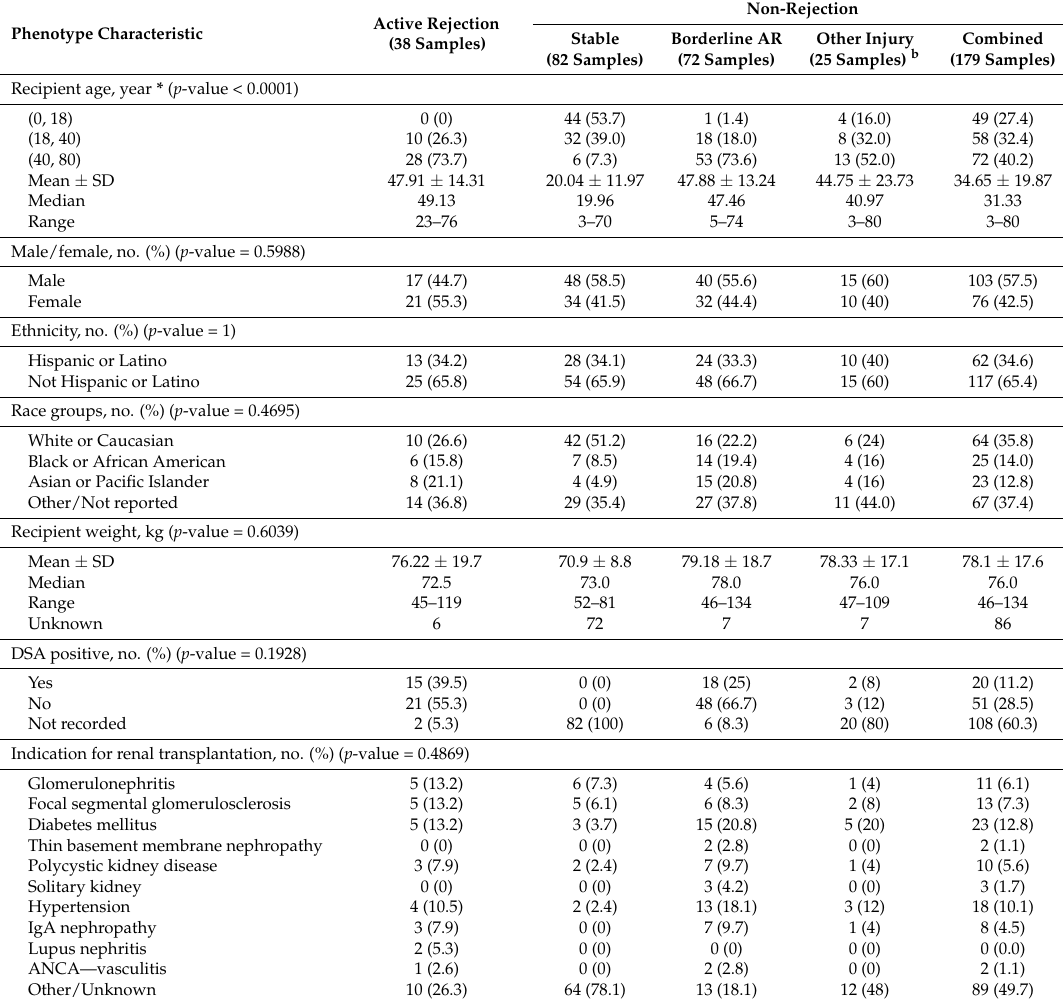
Table 1. Demographics and characteristics a